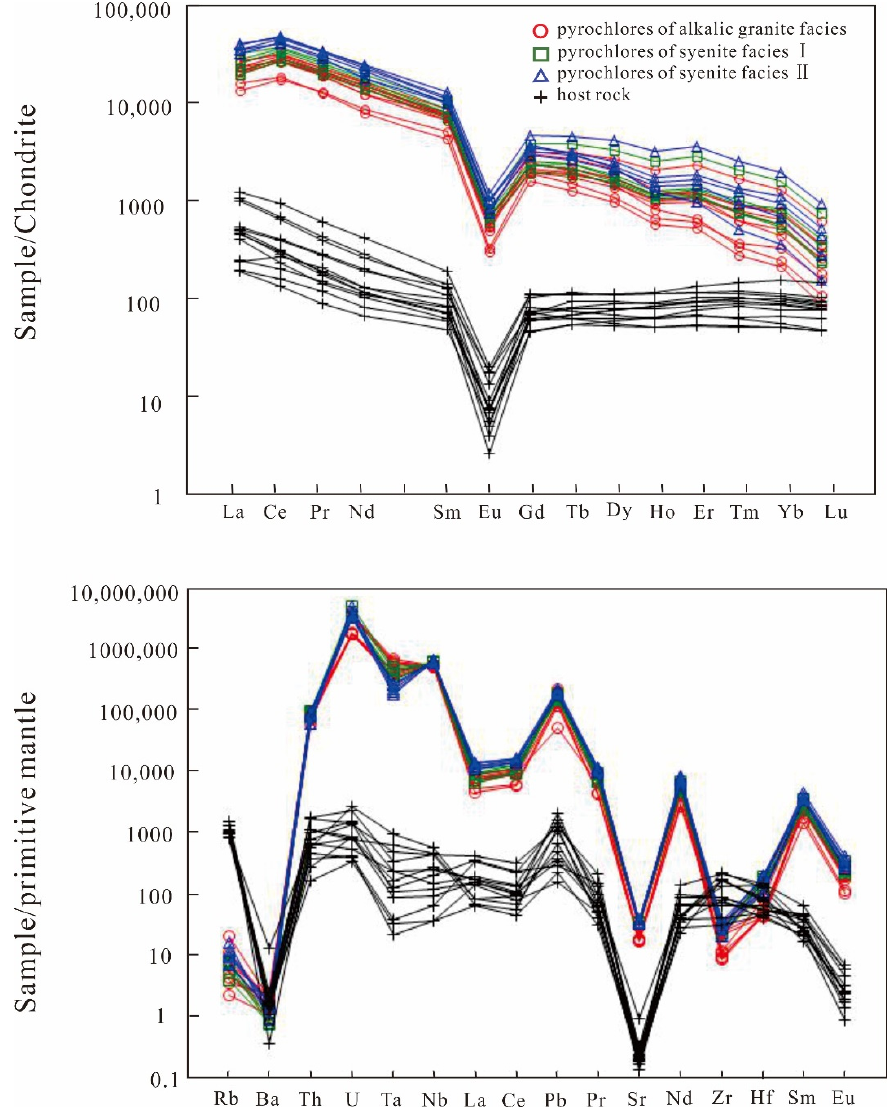
Figure 9. Chondrite-normalized REE patterns and primitive mantle-normalized trace element pat- terns for Boziguoer pyrochlore supergroup minerals and the host rock. The chondrite and primitive mantle values are from [71].